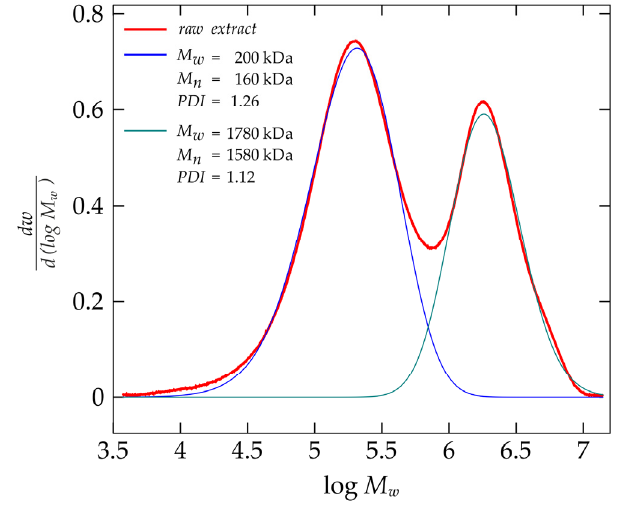
Figure 1. Molecular weight distribution of the polymer chain in the raw Plantago ovata extract.